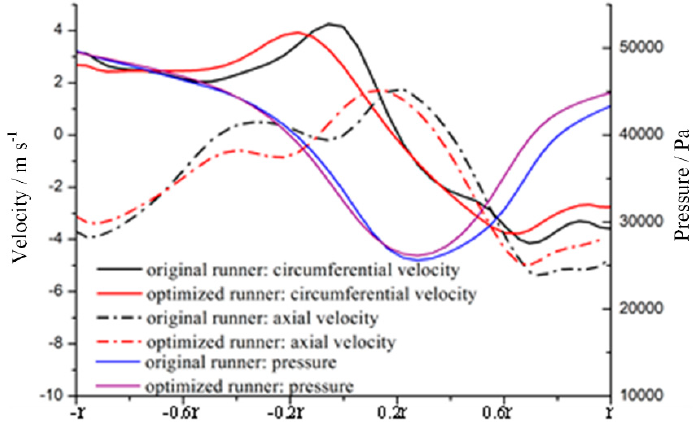
Figure 10. Velocity and pressure distributions along a diameter L1.